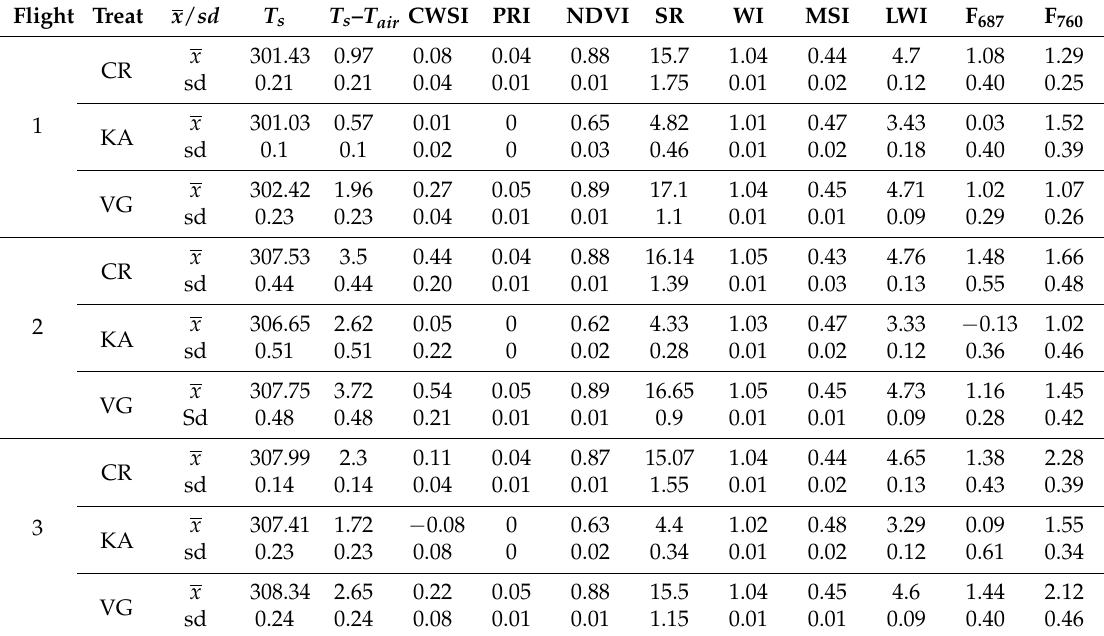
Table A1. Descriptive statistics: mean ( x ) and standard deviation ( sd ) for every index per flight and treatment (Control (CR), Kaolin (KA) and Vapor Gard ® (VG)).